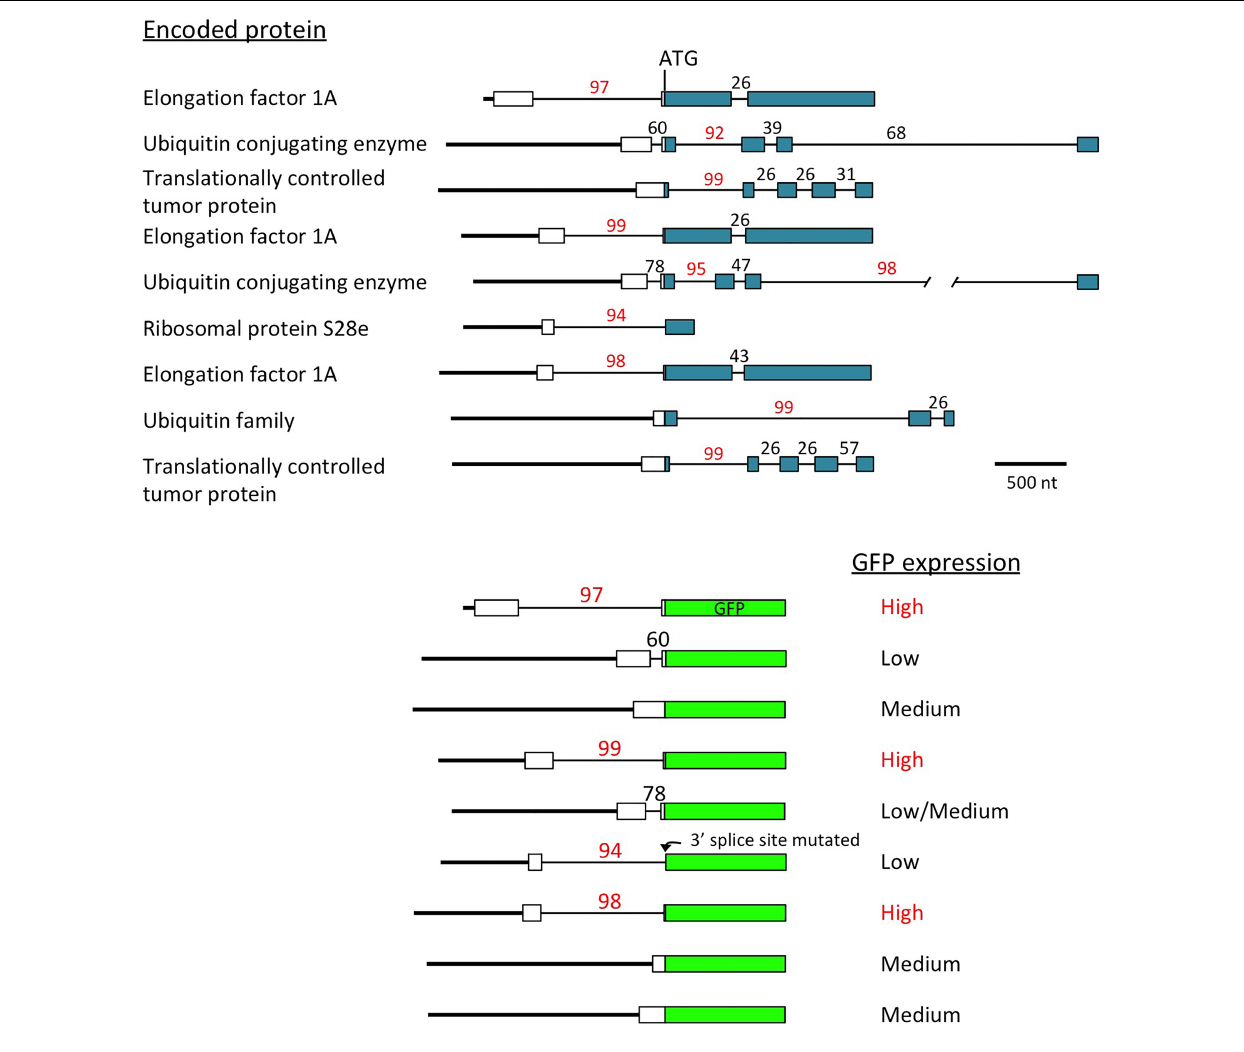
FIGURE 2 | Introns may regulate the most highly expressed genes. Top: scale diagrams of the genes identified by Zhang et al. (2015) as producing the most mRNA throughout soybeans, aligned on their translational start codons. White rectangles indicate 5 (cid:48) -UTRs, colored boxes represent coding sequences, thick lines are promoters and thin lines are introns. IMEter scores (http://korflab.ucdavis.edu/cgi-bin/IMEter_2014/web-imeter2.1.pl) are shown above each intron as a percentile. Bottom: the promoter of each gene was fused to GFP at the start codon, and the GFP activity produced by each construct is described (Zhang et al., 2015). One intron very close to the start codon had its 3 (cid:48) splice site mutated by the restriction site created to make the fusion, probably preventing GFP expression if the intron is not spliced or uses an alternative 3 (cid:48) splice site in